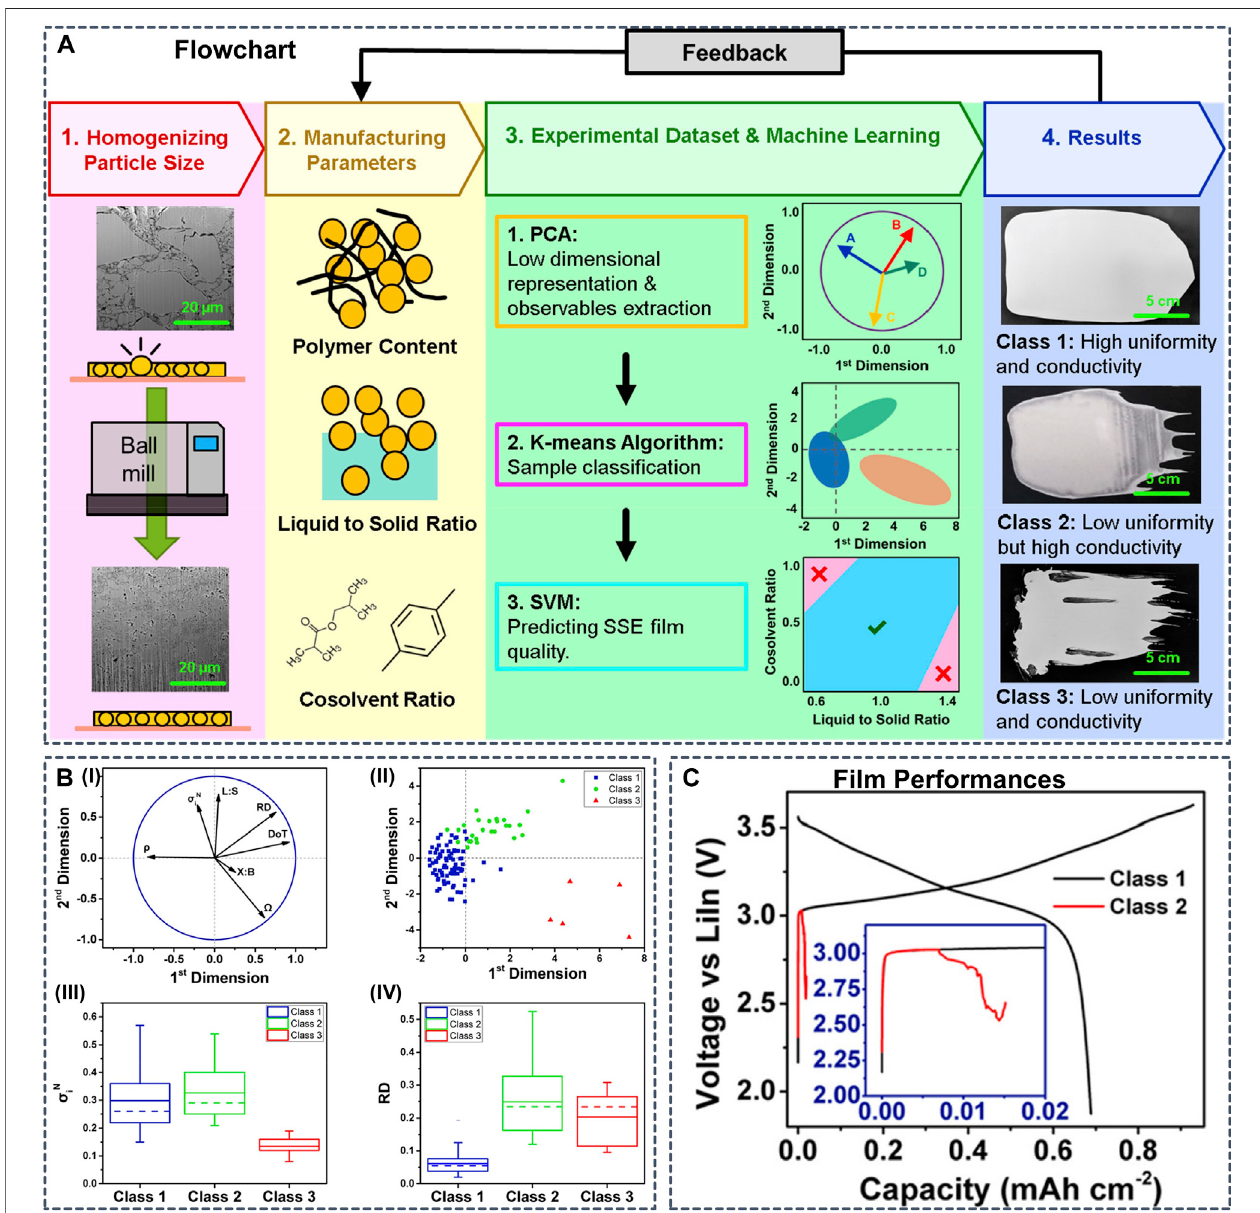
FIGURE 12| (A) Schematic presenting the methodology developed in this work. First, ball-milling is used to reduce the particle sizeof the LPSCl electrolyte. Then, 110 slurries consisting of different polymer contents, liquid-to-solid ratios, and cosolvent ratios are fabricated to obtain the data set. This data set is fed into the machine learning work fl ow to categorize samples with different properties, as shown in the fourth step (B) Data analysis results coming from the implementation of the PCA and the K-means algorithm which show the linear dependence between initial variables and the grouping of the samples in terms of performance, respectively (B-I) Projectionoftheinitialvariables(symbolizedbyblackarrows)ontothe2Dplanformed bythe fi rsttwoprincipalcomponents resultingfromthePCAimplementation,with the purpose to visualize and analyze the correlation between each pair of variables. For the PCA implementation, P% is not taken into account because of alow number of different modalities. It is considered as a qualitative variable and did not appear in the initial PCA features for better results. However, P% is used for the rest of the analysis (B-II) All samples are grouped into three clusters with the K-means algorithm, here represented within the two fi rst principal components. Those clusters are explicitlyde fi nedasclassesintherestofthestudy.Boxchartsforthecomparison ofdistributionof (B-III) normalized conductivityand (B-IV) relative thicknessdeviation for all three classes. Abbreviations: L:S, liquid-to-solid ratio; X:B, cosolvent ratio; ρ , density; Ω , ohmic resistance; σ iN , normalized conductivity; DoT, deviation of thickness; RD, relative thickness deviation (C) First cycle voltage pro fi les of NCM811 || LPSCl || LiIn cells prepared using SSE fi lms from class 1 and class 2. Because of lower uniformity, the cell using the class 2 fi lm shorts during the fi rst cycle. Reproduced with permission from (Chen et al., 2021). Copyright 2021 American Chemical